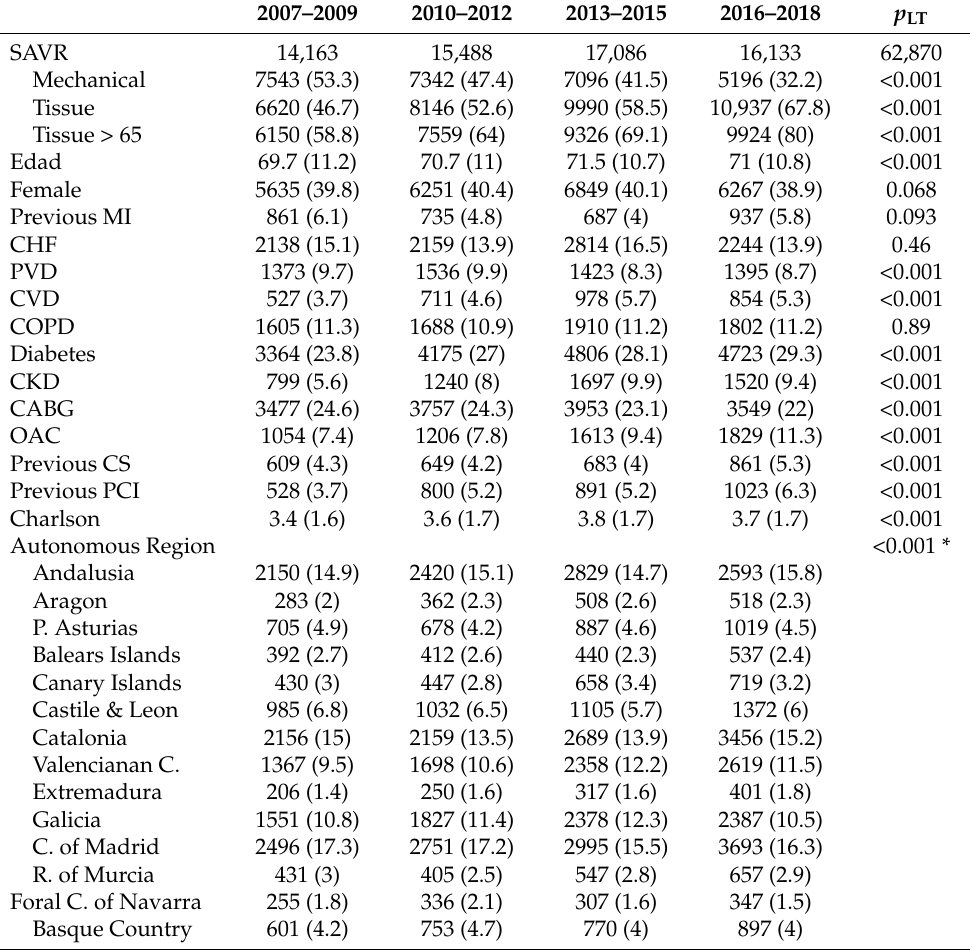
Table 2. Distribution of baseline characteristics according to the study